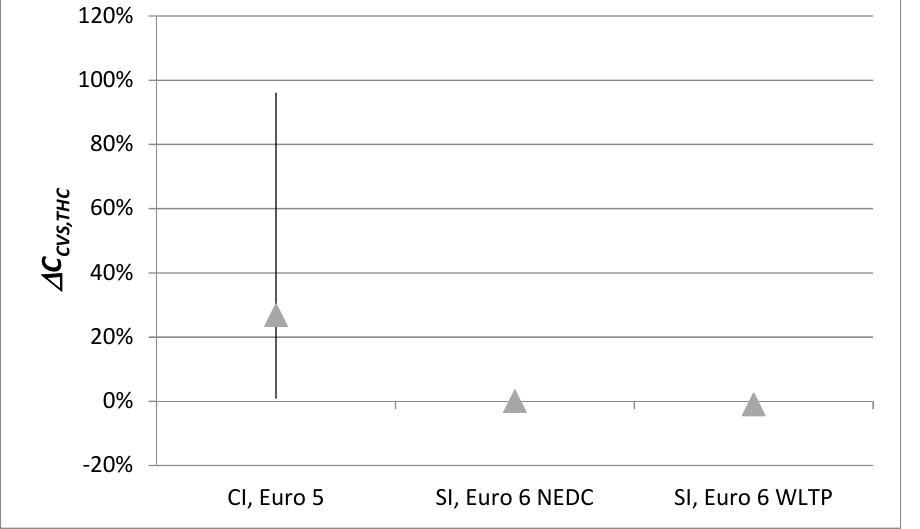
Figure 14. Relative percentage difference in determining the C CVS,corr concentration of the pollutant as calculated from dilution ratio DR (19) and dilution factor DF (3) for THC .